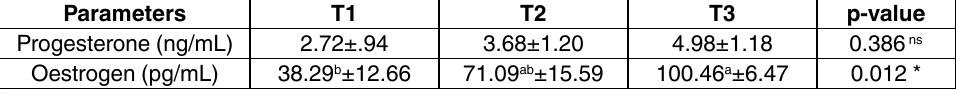
table 2. Sex hormonal parameters 1 of buffalo heifers maintained on three experimental rations Parameters